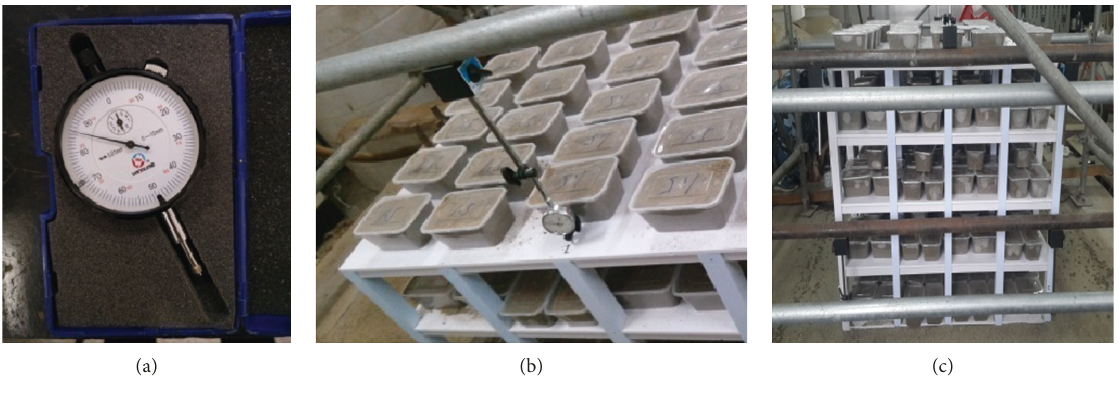
Figure 8: Dial indicators for measure displacement.